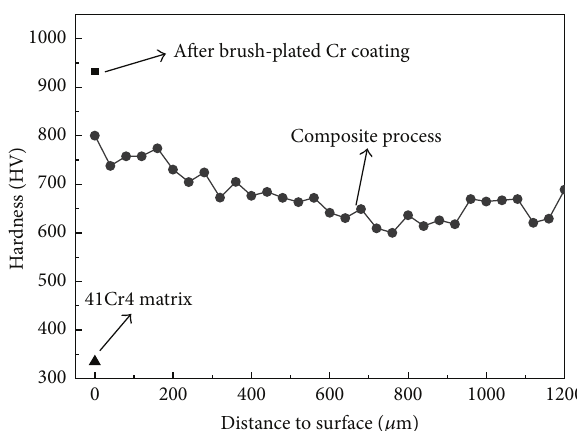
Figure 3: Microhardness plotted as a function of depth to the sample surface.